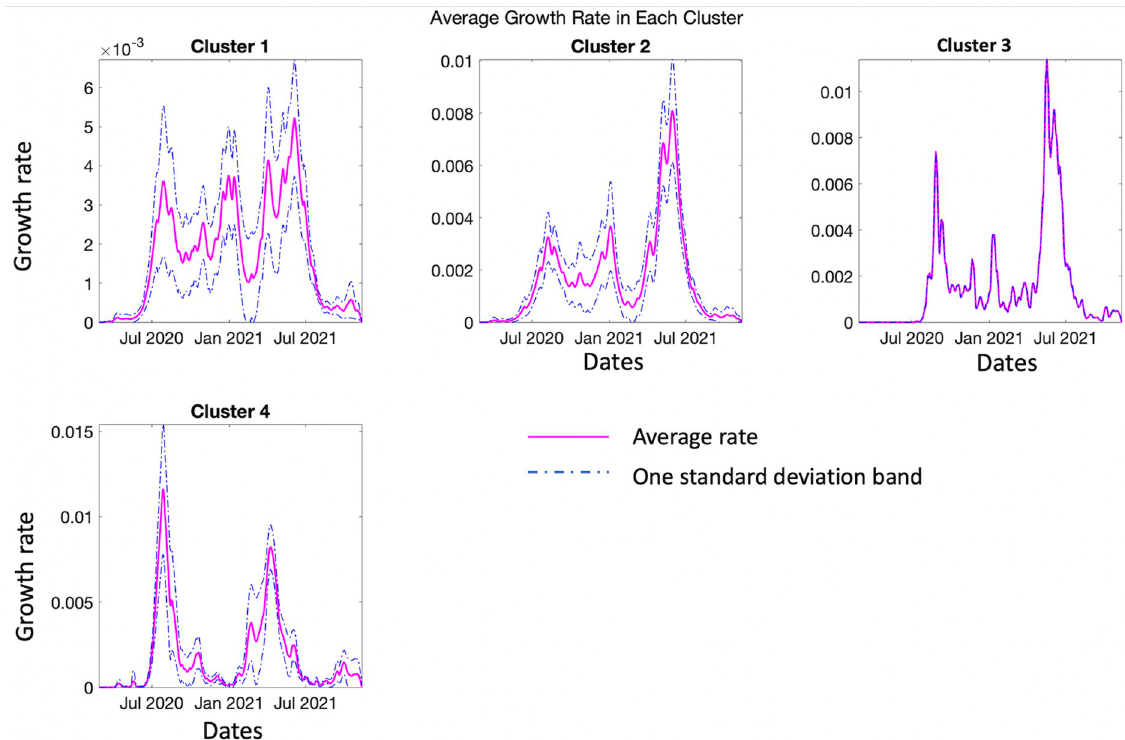
Fig 12. Average shapes of the COVID-19 incidence rate curves, along with a one standard-deviation band around the average, in each of the clusters.